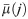
The mean firing count, the Fano factor, and the correlation coefficient of the Poisson spike trains with inactive period Tr.(A, B) Temporal changes in the mean μ¯(j) of the firing count for (A) Tr = 7 and (B) Tr = 12. The values of λ2 are chosen to reproduce the results in Fig 5A. (C, D) Temporal changes in the Fano factor F(j) of the firing count for (C) Tr = 7 and (D) Tr = 12. (E, F) Temporal changes in the correlation coefficient of the firing counts for (E) Tr = 7 and (F) Tr = 12.